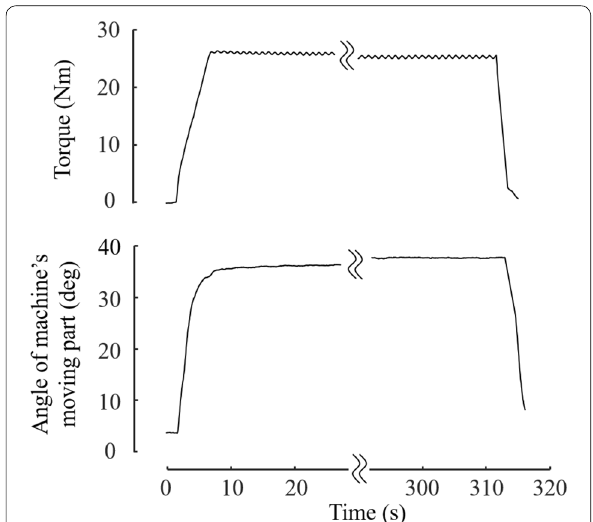
Fig. 4 Example of applied torque and angle of machine’s moving part during 5 min of stretching. Torque was calculated from applied pressure and angle of machine’s moving part